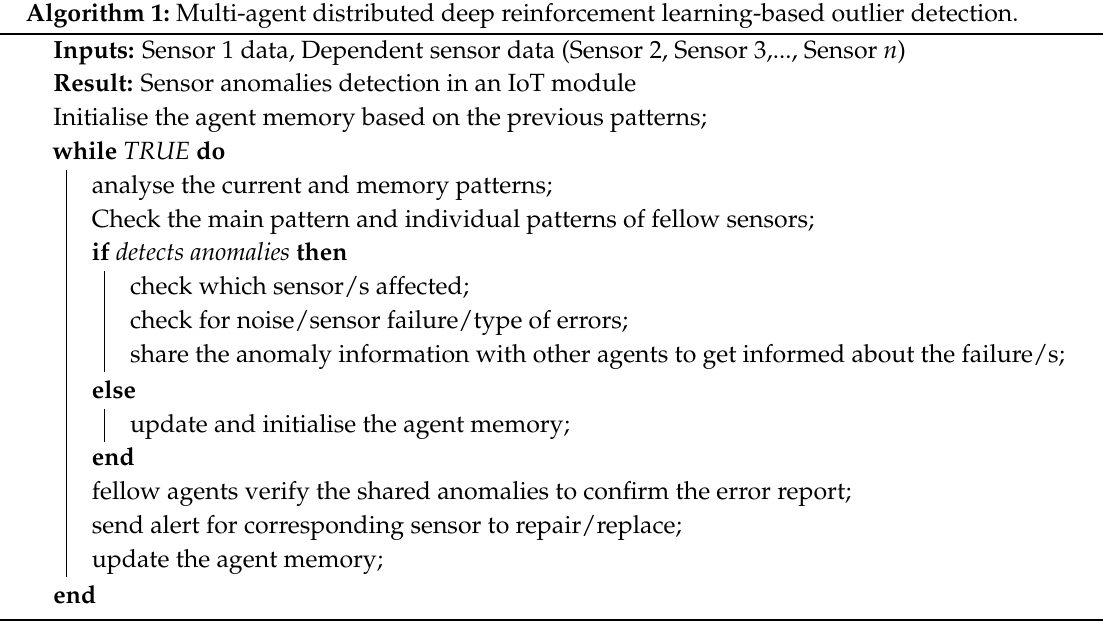
Algorithm 1: Multi-agent distributed deep reinforcement learning-based outlier detection.